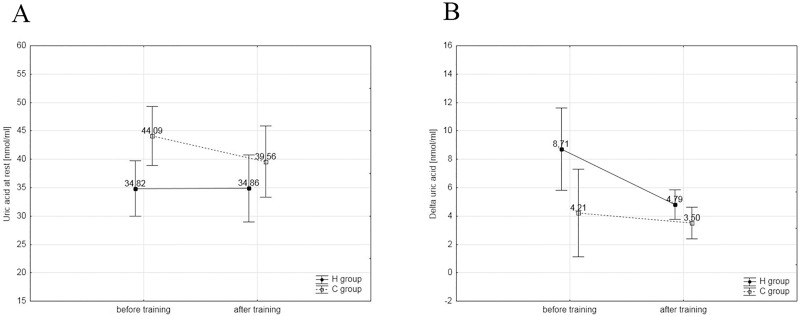
A, B. Changes in uric acid concentration.(A) Changes in resting concentration of uric acid in the experimental (H, n = 8) and control groups (C, n = 7 during the first and last training session. (B) Changes in delta values of uric acid in the H and C groups during the first and last training session.